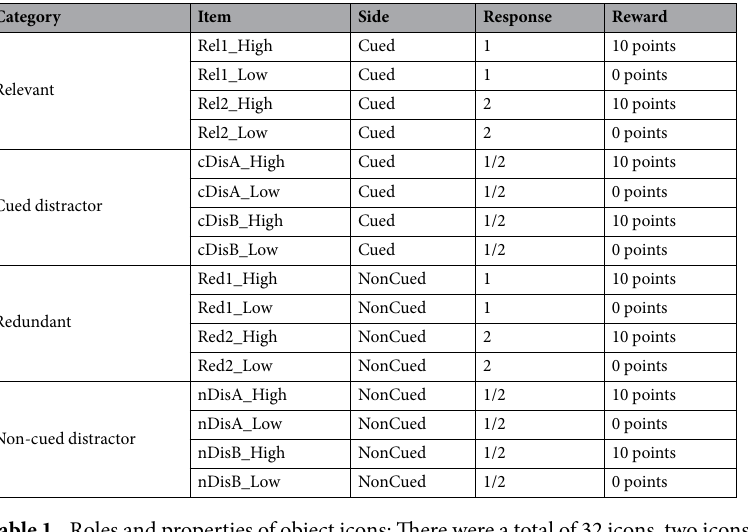
Table 1. Roles and properties of object icons: There were a total of 32 icons, two icons for every entry in the table. All icons were either associated with 10 (high reward) or 0 points (low reward). Relevant and redundant icons were associated with a particular response (1 or 2) whereas distractors were not (A or